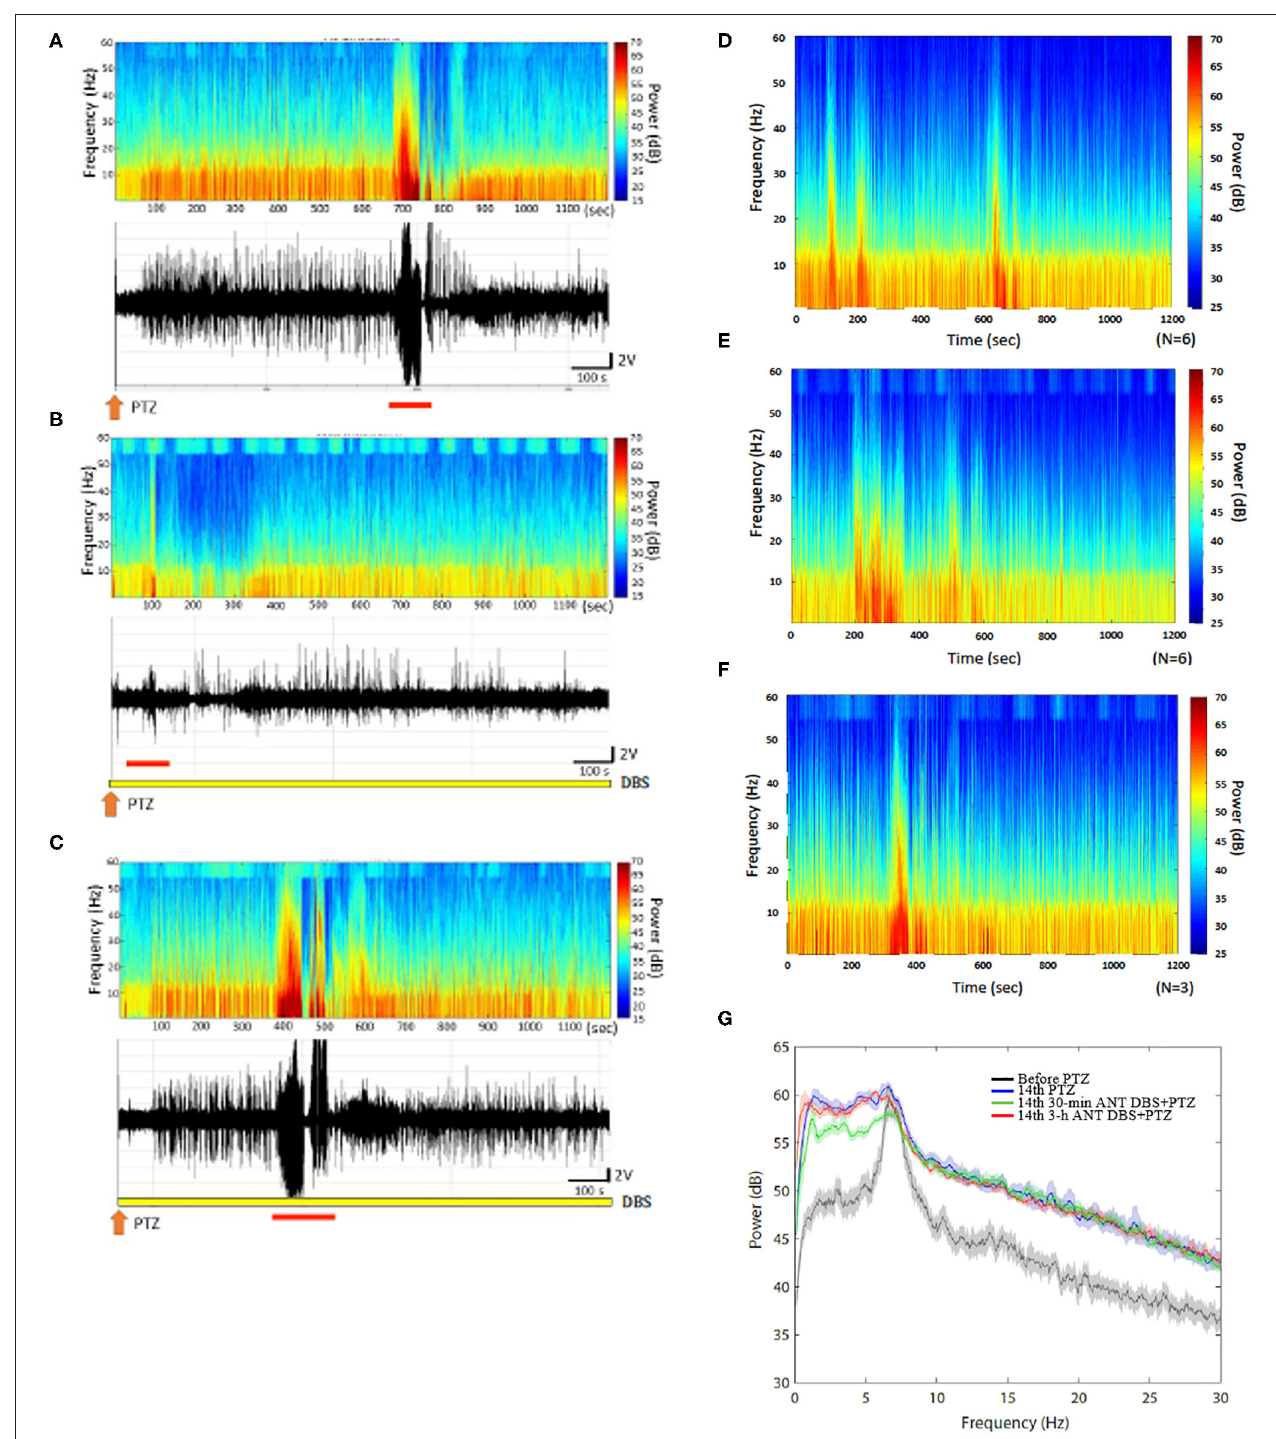
FIGURE 4 | Anterior nucleus of thalamus (ANT) deep brain stimulation (DBS) suppressed the 14th pentylenetetrazol (PTZ) injection-induced enhancement of the power spectrum. (A) The power spectrum and the raw electroencephalogram (EEG) acquired after the 14th PTZ injection in one rat. (B) The power spectrum and the raw EEGs obtained after the 14th 30-min ANT DBS + PTZ in one rat. (C) The power spectrum and the raw EEGs obtained after the 14th 3-h ANT DBS + PTZ in one rat. (D) The average of the power spectrum obtained from a group of rats after the 14th PTZ injection. (E) The average of the power spectrum obtained from a group of rats after the 14th 30-min ANT DBS + PTZ. (F) The average of the power spectrum obtained from a group of rats after the 14th 3-h ANT DBS + PTZ. (G) The summary of alterations in the power spectrum. The orange arrow depicts the injection of PTZ, the yellow bar represents the ANT DBS, and the red bar demonstrates the ictal